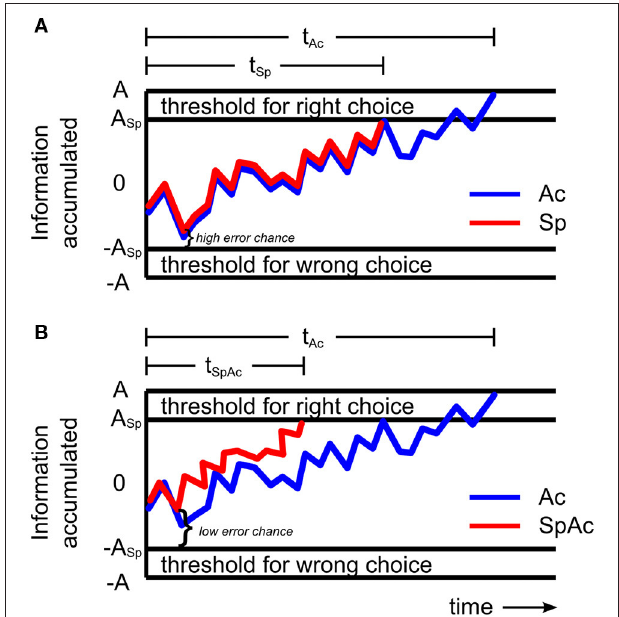
FIGURE 1 | Models of sensory information accumulation during a left-right motion discrimination task. (A) Model with constant drift rate. The plotted graph shows the amount of information a subject may accumulate over time under accuracy (blue line) and speed (red line) emphasis. The subject responds once the accumulated information reaches the response threshold. When only accuracy is emphasized, response threshold A is relatively high resulting in relatively long response time t Ac . When only speed is emphasized, the rate of information accumulated (drift rate) remains the same but response threshold, A Sp , is relatively lower resulting in a shorter response time (t Sp < t Ac ) and higher chance for error. (B) Model with increased drift rate. When both speed and accuracy are emphasized, response threshold, A Sp , may be relatively low, while drift rate becomes relatively fast (red line) resulting in shorter response times (t SpAc < t Ac ) and lower chance for error. By increasing drift rate sufficiently to overcome accuracy losses which would have been caused by a reduction in response threshold, subjects can make decisions with high levels of both speed and